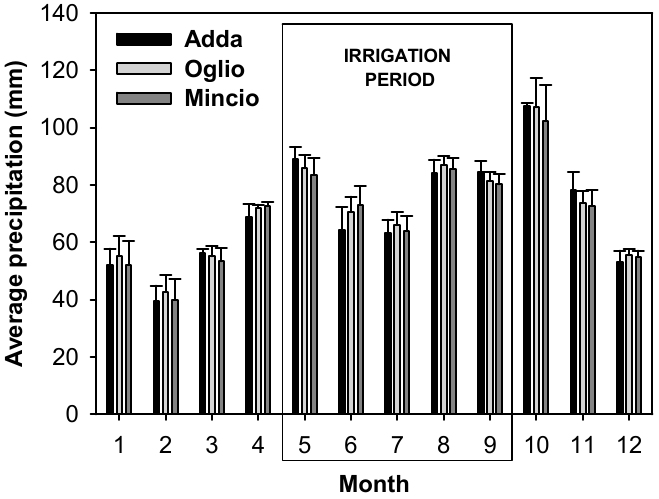
Figure 3. Monthly precipitation in the Adda, Oglio, and Mincio watershed portions considered in the present study. Average values ( ± standard deviation) of the period 1960–1990 are reported. Data source: [52,53].